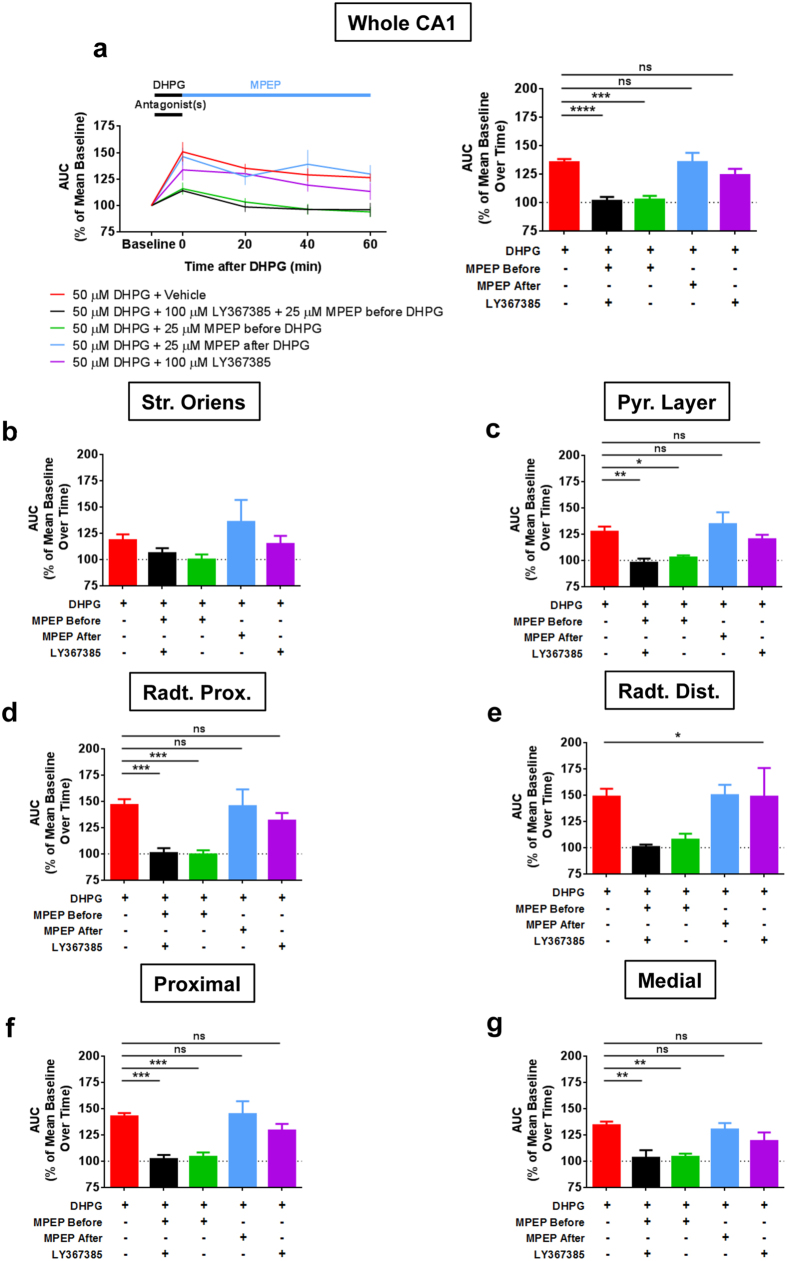
Long-lasting increase of fIPSPs after DHPG application is mediated by mGlu5 activation.Slices were incubated with DHPG in presence of antagonists of group-I mGlu receptors (LY367385 for mGlu1, MPEP for mGlu5 or both), which were kept until the end of DHPG application, except when MPEP has been applied after DHPG (represented in blue). In (a), left panel shows time course, while bars in right panel represent averaged drug effects over time. In (b–g), bars are the mean over time for each condition at the indicated region. One-way ANOVA followed by Dunnet post-hoc test has been used to assess differences between groups in (a) (right panel) and (b–g). In radiatum distal (e) there is a significant ANOVA (F(4, 27) = 2.912, p = 0.04) but not significant Dunnet’s multiple comparisons test. n = (slices, mice): Vehicle group = (7, 7), LY367385 + MPEP before group = (7, 7), MPEP before group = (6, 5), MPEP after group (5, 4), LY367385 group = (7, 5). Data are mean ± s.e.m. **p < 0.01, ***p < 0.001, ****p < 0.0001, ns = not significant.